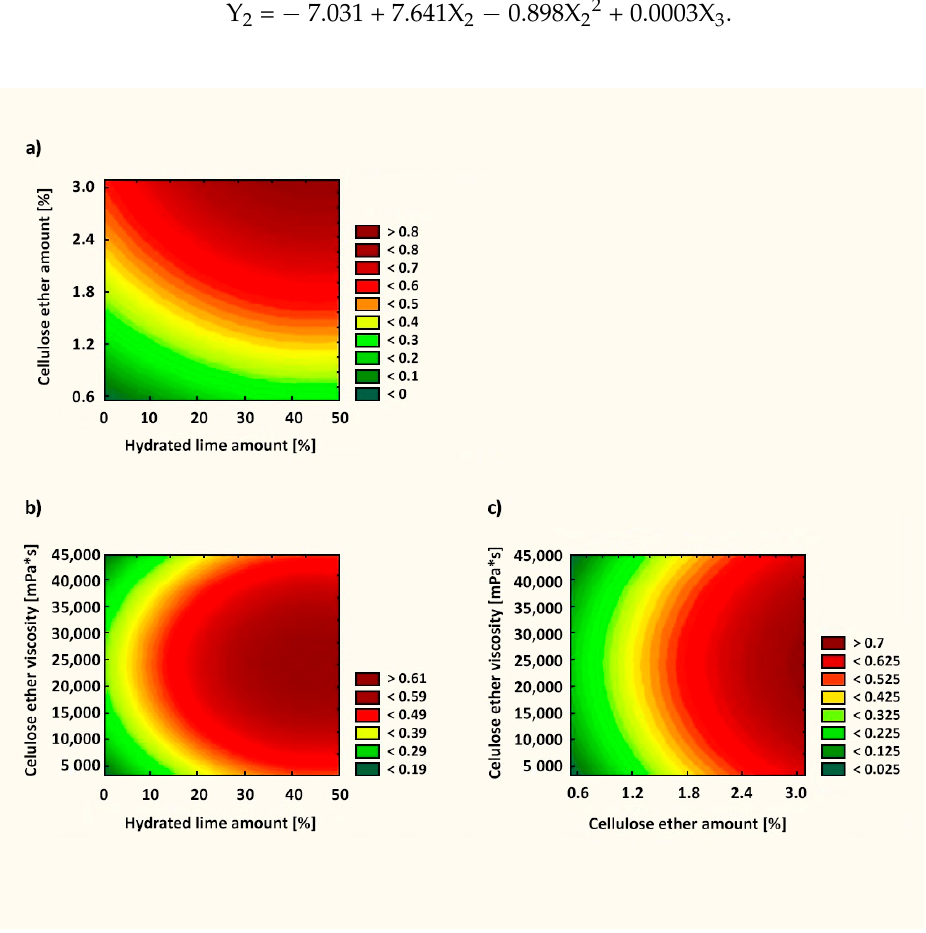
Figure 9. Utility function for the plastic viscosity after 10 min of pastes: ( a ) correlation between cellulose ether amount and hydrated lime amount; ( b ) correlation between cellulose ether viscosity and hydrated lime amount; ( c ) correlation between cellulose ether viscosity and cellulose ether amount.